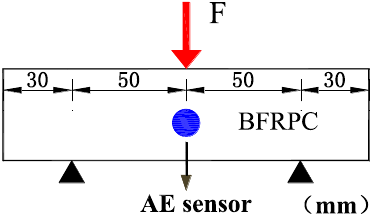
Figure 3. Flexural test and sensor layout. BFRPC, Basalt fiber reactive powder concrete.